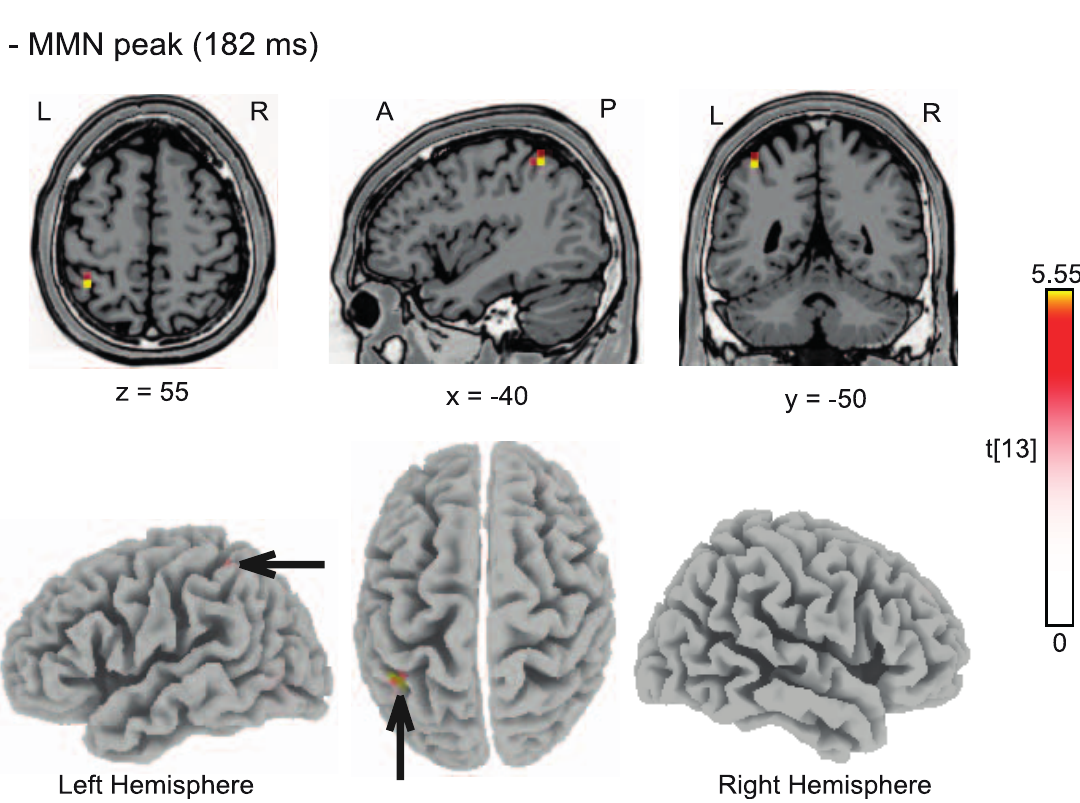
Figure 3. Source localization. (A) sLORETA source reconstruction for the N1 component of the craniocentric deviants versus standards (measured in trials preceding the craniocentric deviants). Functional data from all subjects were projected onto the standard 3-D MNI brain template ‘‘Colin’’ of sLORETA. Red and yellow color coding indicates t -values with statistically significant activation for deviants compared to standards at t $ 5.29; p , 0.05,